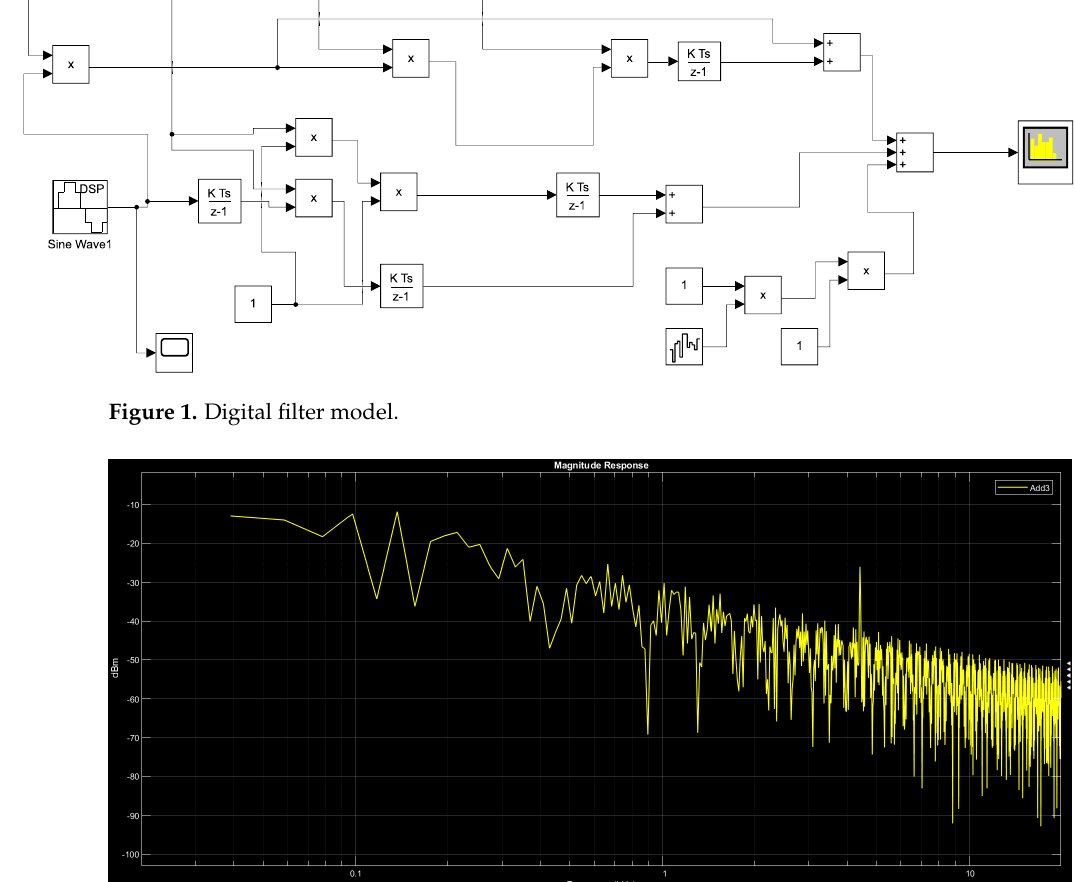
Figure 2. Magnitude